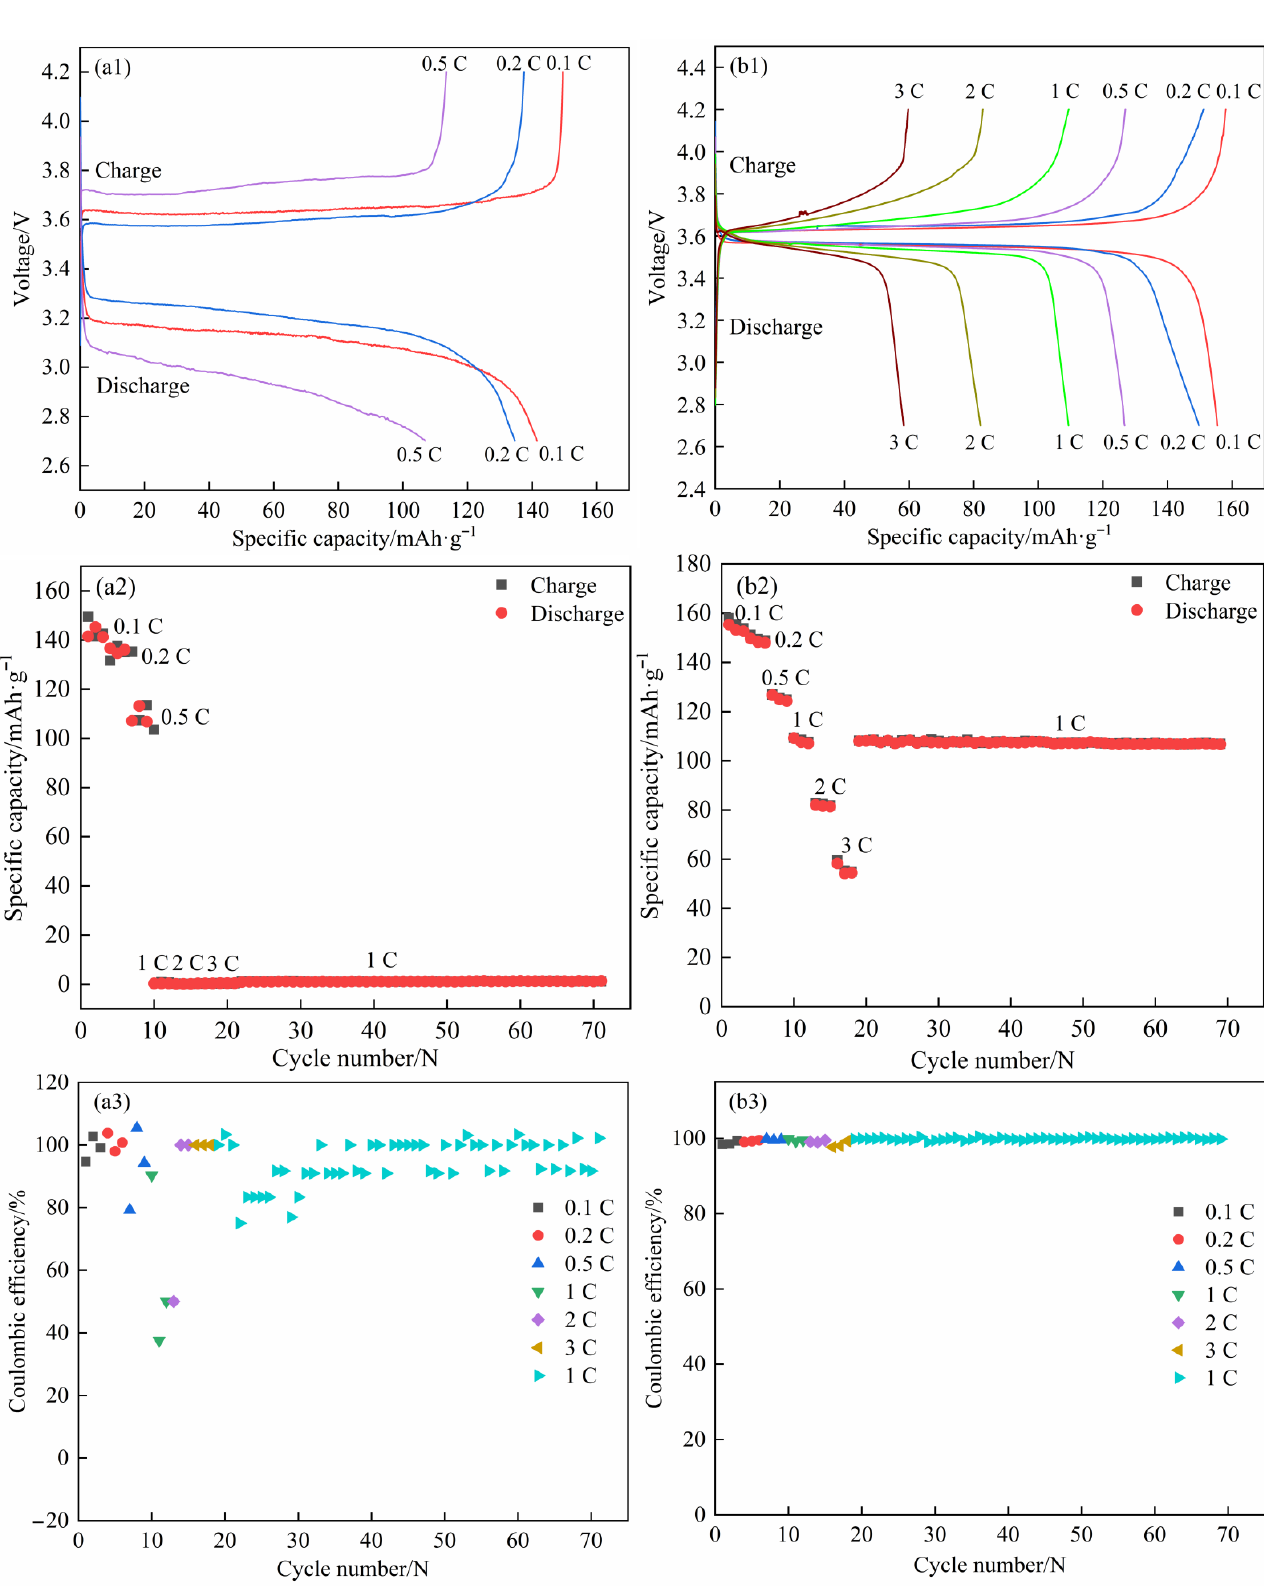
Figure 7. The rating performance of LFP/SPEs/Li coin cells at 60 °C. ( a1 – a3 ) Zero wt.% ZnO [26], ( b1 – b3 ) 3 wt.% ZnO.